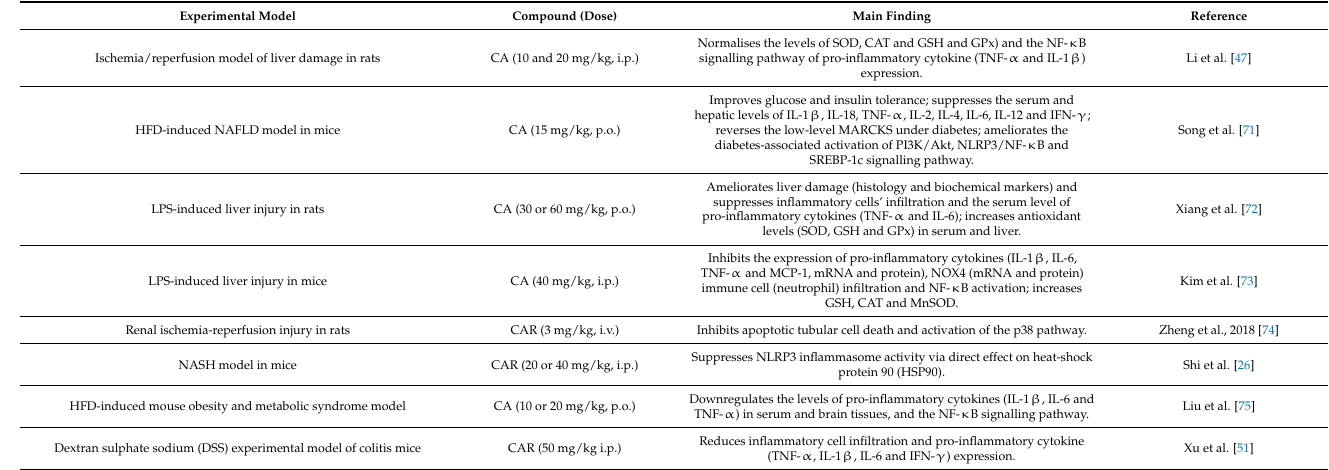
Abbreviations: See also Table 1 legend. A β , β -amyloid; AChE, acetylcholinesterase; AD, Alzheimer’s disease; ARDS, acute respiratory distress syndrome; CAT, catalase; GGT, gamma-glutamyltransferase; HDL-C,